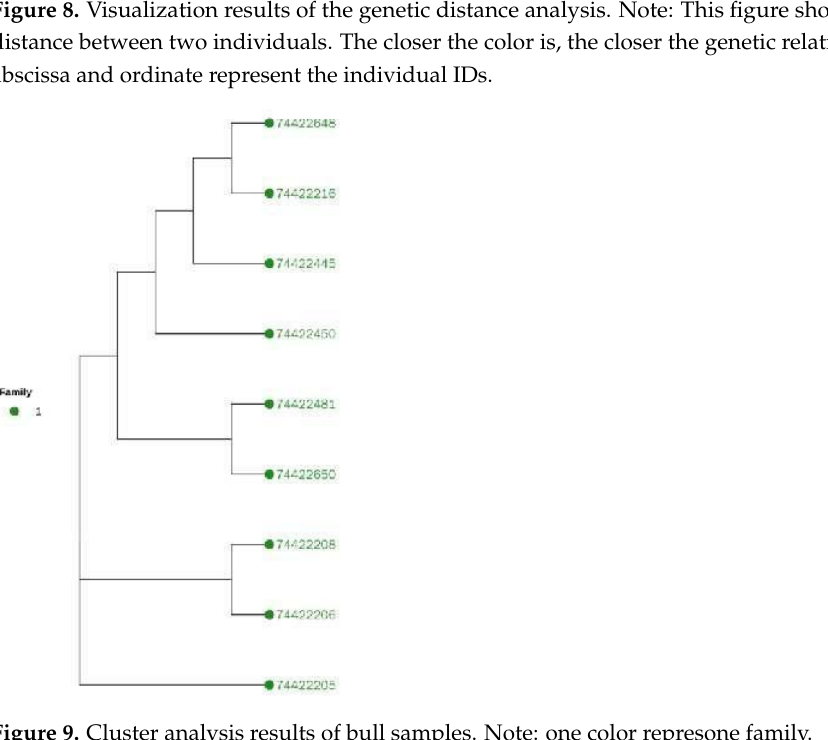
Figure 10. Clustering analysis results of all samples. Note: the color marked in the evolutionary tree is the bull sample, and one color represents a family. 3.7. Family Structure Analysis of Altay White-Headed Cattle Conservation Population Combined with the results of the genomic kinship analysis and cluster analysis, the existing bull samples were divided into one family. The standard for clustering is that the genomic kinship coefficient between bulls is greater than or equal to 0.1. According to the kinship between the existing cows and bulls, different families were established. In addi- tion, it was found that 30 cows were distant from the detected bulls. Therefore, they were classified into the “other” category (see Table 3 for the results). Table 3. Results of population and family construction. Family 1 Male Altay White-Headed Cattle